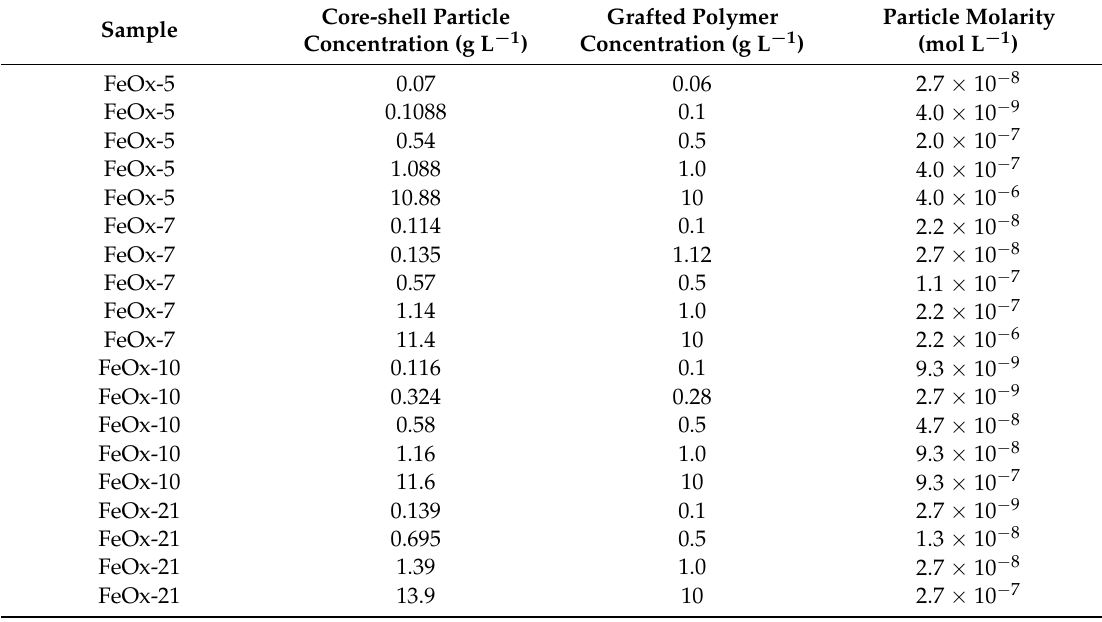
Table 1. Comparison of particle and polymer concentrations for different core-shell nanoparticle